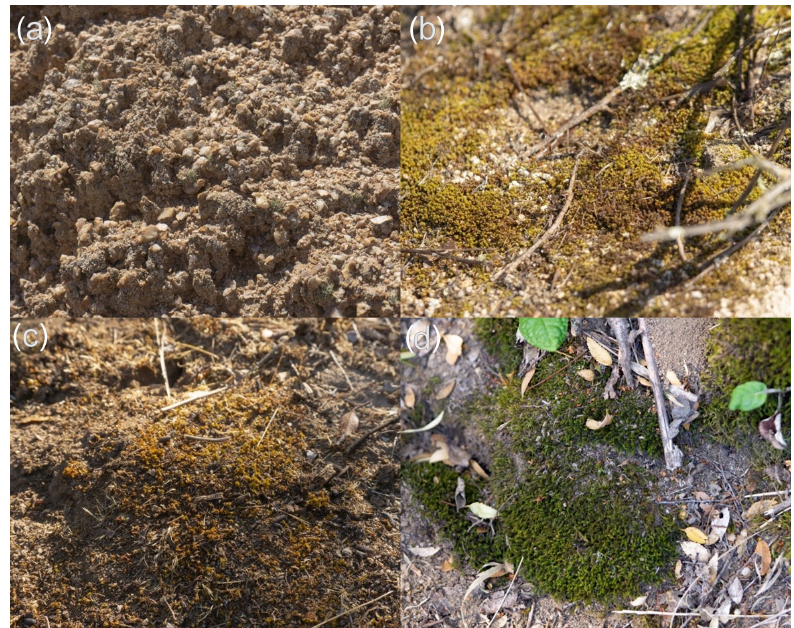
Figure 1. Sampled biological soil crust for PA (a) , SG (b) , LC (c) , and NA (d) . Table 1. Taxonomical composition of mosses and lichens in the biological soil crust for the study sites along the climatic gradient.